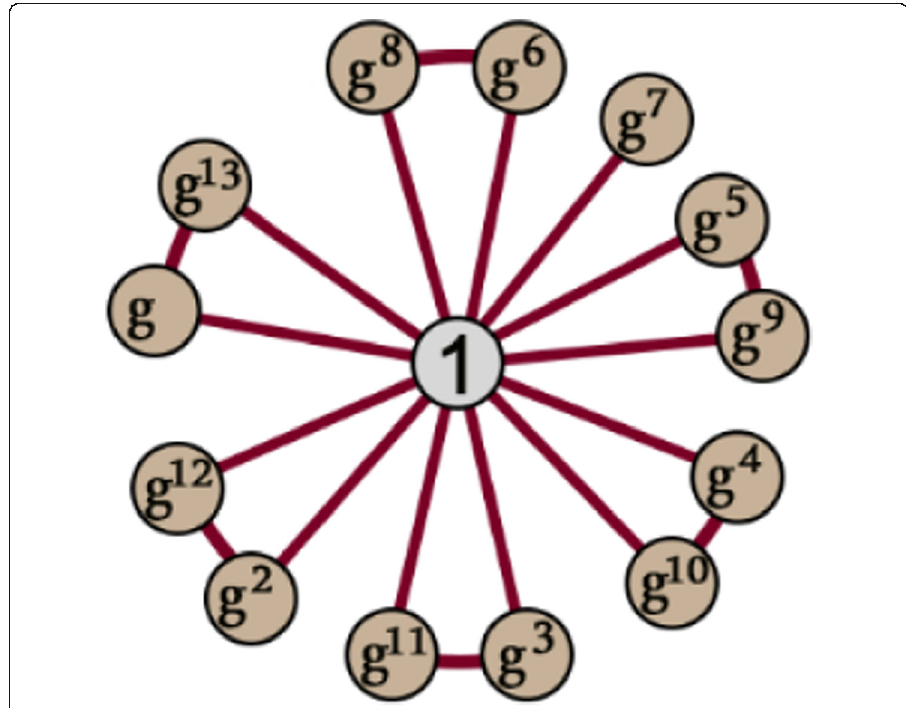
Fig. 1 An identity graph for the cyclic group G = 〈 g | g 14 = 1 〉